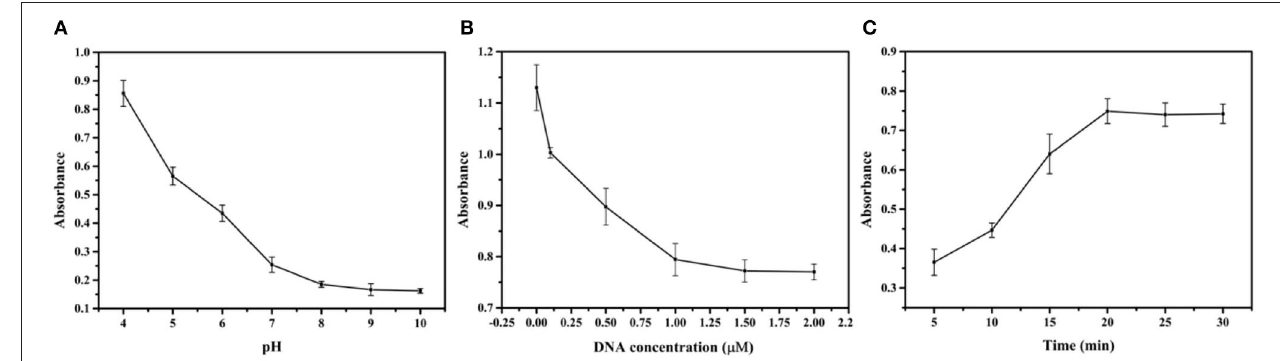
FIGURE 3 | Optimization of the experimental conditions. (A) pH; (B) DNA concentration; and (C) reaction